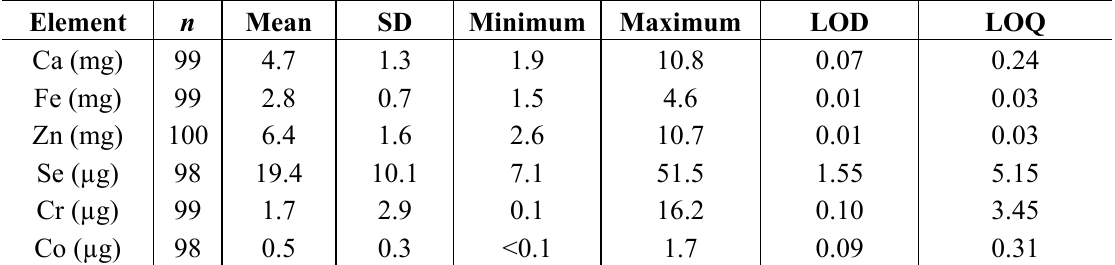
Table 2. Overall mean concentrations of the selected essential elements per 100 g raw meat. Element n Mean SD Minimum Maximum LOD LOQ Ca (mg) 99 Fe (mg) 99 Zn (mg) 100 Se (µg) Cr (µg) Co (µg)